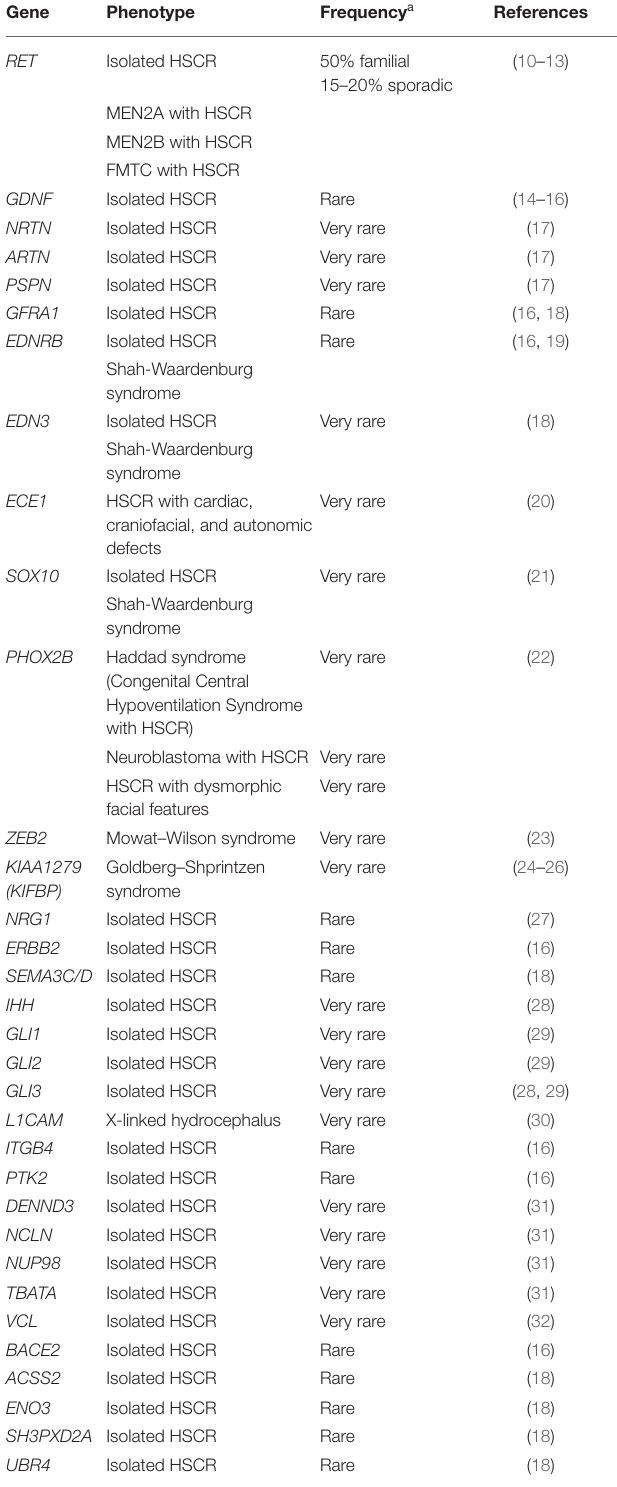
Table is updated and adapted from (2) and (33). a Rare: Variants detected in 1–7% of patients with HSCR screened and reported. Very rare: Variants detected in < 1% of the patients with HSCR screened and